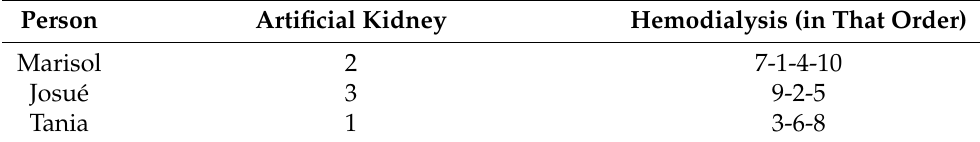
Table A6. Nurses schedule for hemodialysis.